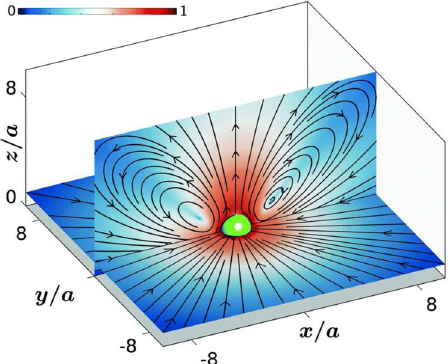
Fig. 4 Flow around the bubble. The cross-section of the streamlines of fl uid fl ow around a bubble of radius a in planes parallel and perpendicular to the wall (the wall is the gray plane at z = 0) and the bubble is the represented by the green sphere. It can be seen that the fl ow has cylindrical symmetry and draws the fl uid from all directions. The streamlines of the fl uid fl ow are drawn over the pseudo-color plot of the normalized logarithm of the fl ow speed. Figure and caption are taken from ref. 66 — reproduced by permission of The Royal Society of